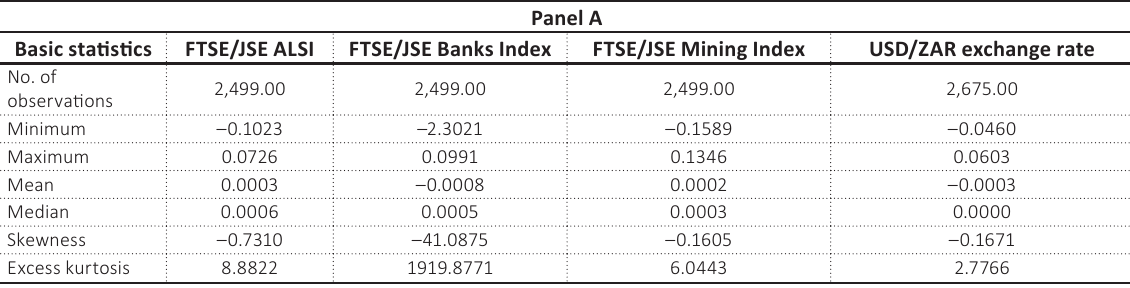
Table 1. Descriptive statistics of financial stock market indices and exchange rate price returns Panel